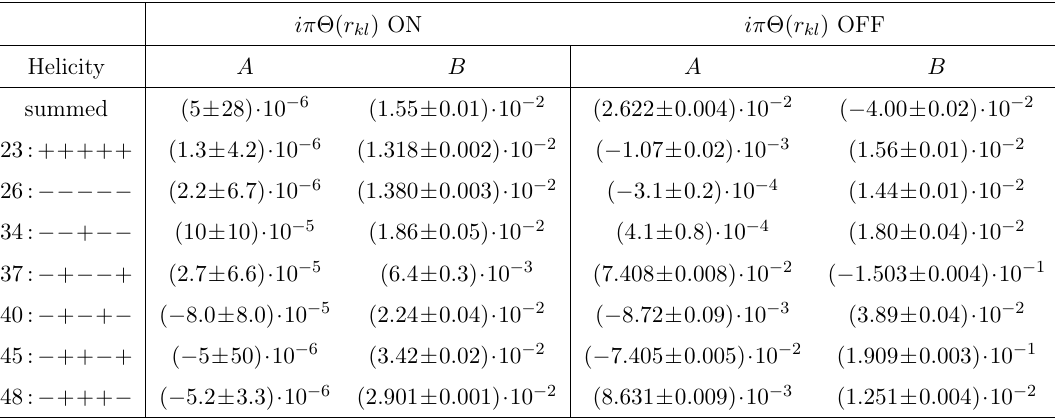
Table 1 . Result of the fit of the quantity (Virt-SDK)/LO using the method of least squares and the function (6.2) for the representative process d (cid:22) d ! Zd (cid:22) d at O ( (cid:11) 3 ) . The case including(excluding) the contribution of i(cid:25) (cid:2)( r kl ) corresponds to the quantities shown in the second(third) inset of the upper-left plot of figure